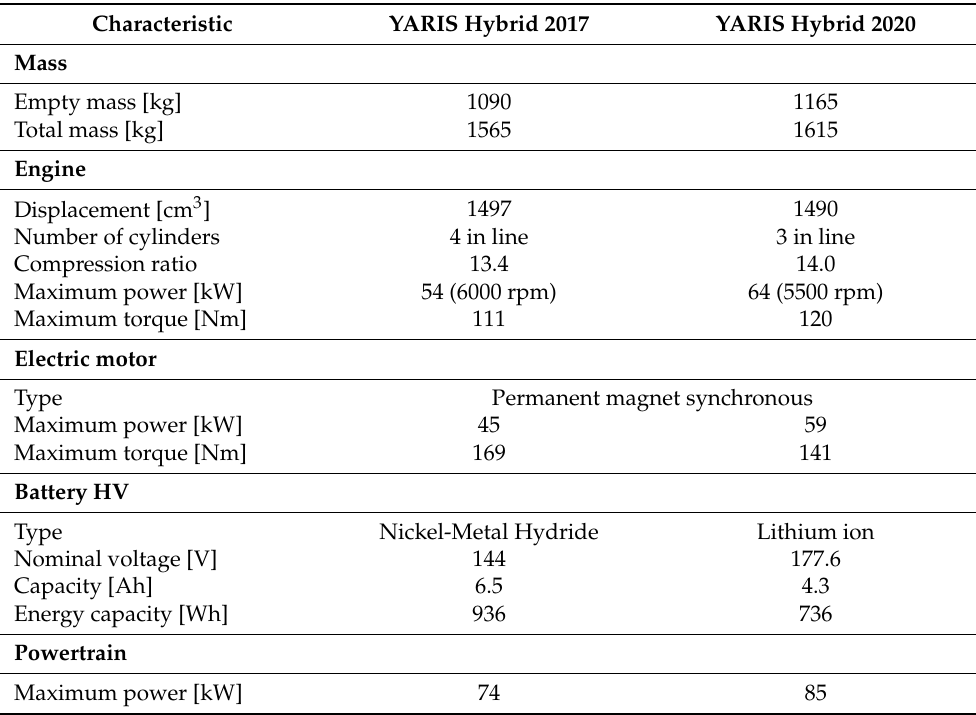
Table 1. Main features of the two Toyota hybrid Yaris